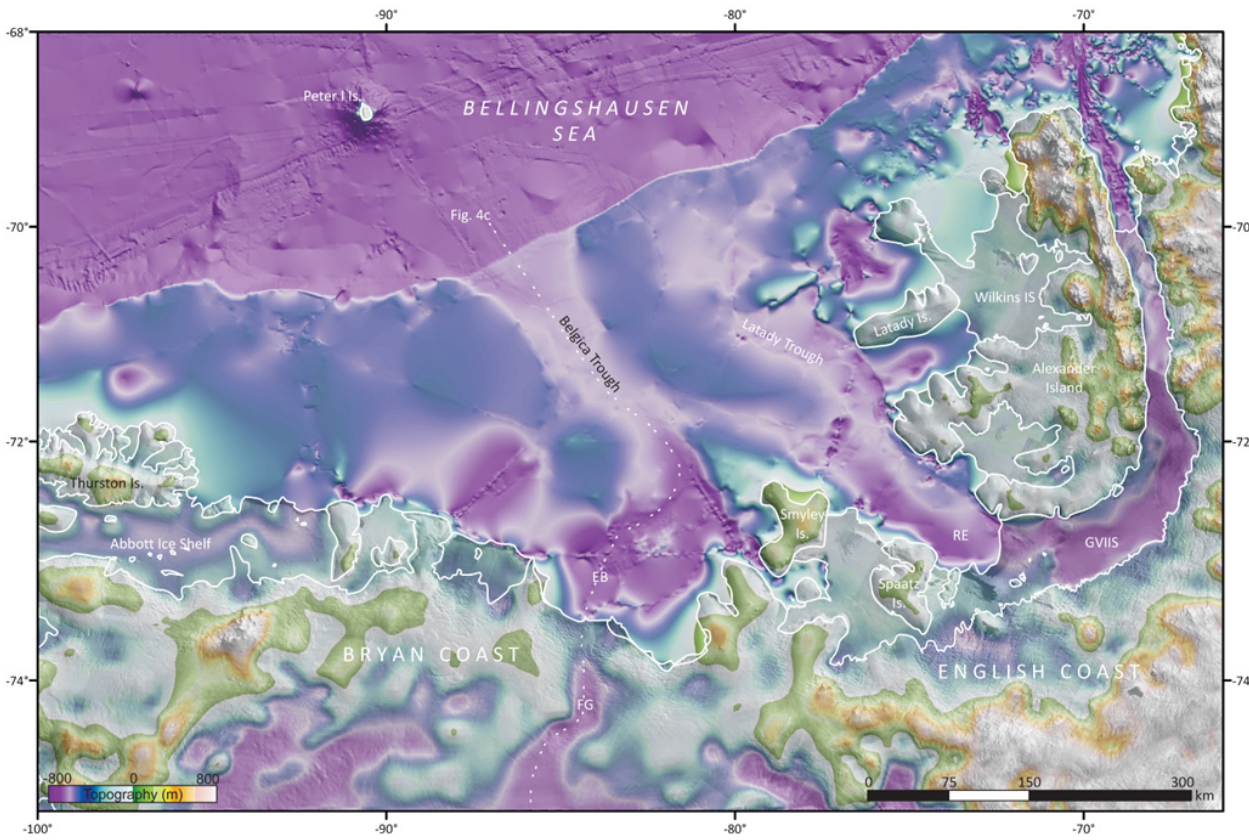
Fig. 2. Bathymetry of the Bellingshausen Sea. Grid cell size 1000m. Coastline drawn from the ADD v.4.1. and areas of the ice sheet are draped by a semi-transparent version of the LIMA raster image. Grid is compiled in South Pole stereographic projection, but shown here in Mercator WGS84 projection. The map is rendered here to accentuate shelf and sub-ice features, but a map highlighting deep-ocean features is shown in Fig. 3. Large format plot of the grid is available as Supplement Fig.